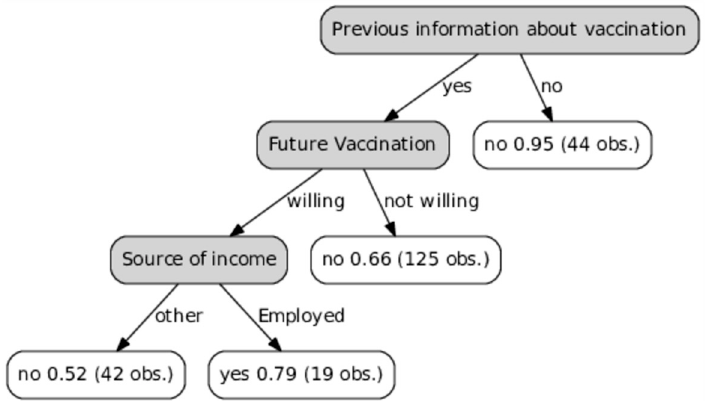
Figure 2. Decision tree illustrating how previous information about vaccination determines vaccinating an elderly patient against seasonal influenza.